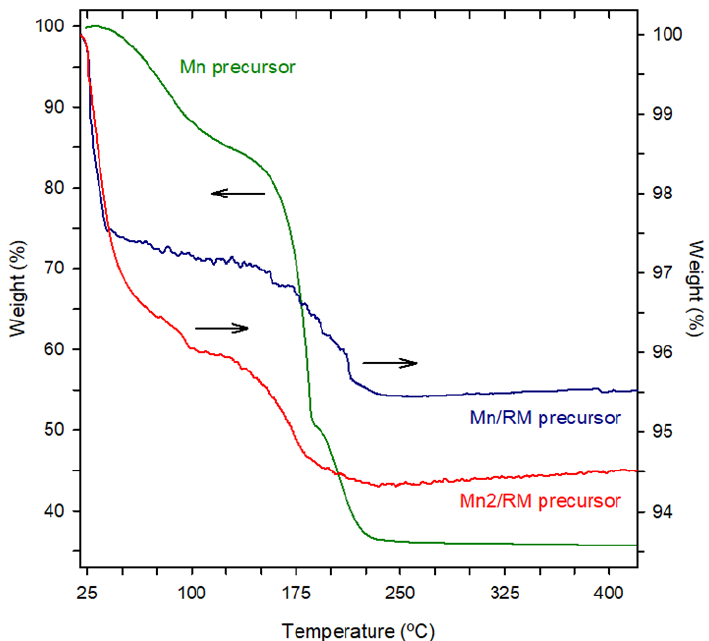
Figure 2. Thermogravimetric analysis curves of the manganese phase and catalysts precursors. The results of the study by XRD are shown in Figure 3. As it can be seen, the diffrac- tograms are dominated by the peaks, which are characteristic of the cordierite support (Mg 2 Al 4 Si 5 O 18 phase), including those of Ce 2 Zr 2 O 7 (pyrochlore), usually present in the cordierite washcoating of TWCs. However, in the case of Mn/RM, peaks attributable to Mn 3 O 4 (hausmannite) (PDF codes = 000-24-0734) can be also detected, whereas both Mn 3 O 4 and Mn 2 O 3 (bixbyite) phases (PDF codes = 000-04-0732 and 000-41-1442, respectively) are identified in Mn2/RM. This proves that the active phase has been efficiently deposited over the RM